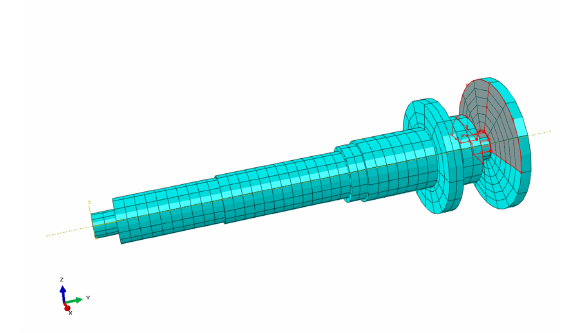
Figure 2: The finite element model of the micro-turbine rotor with surfaces having a temperature of